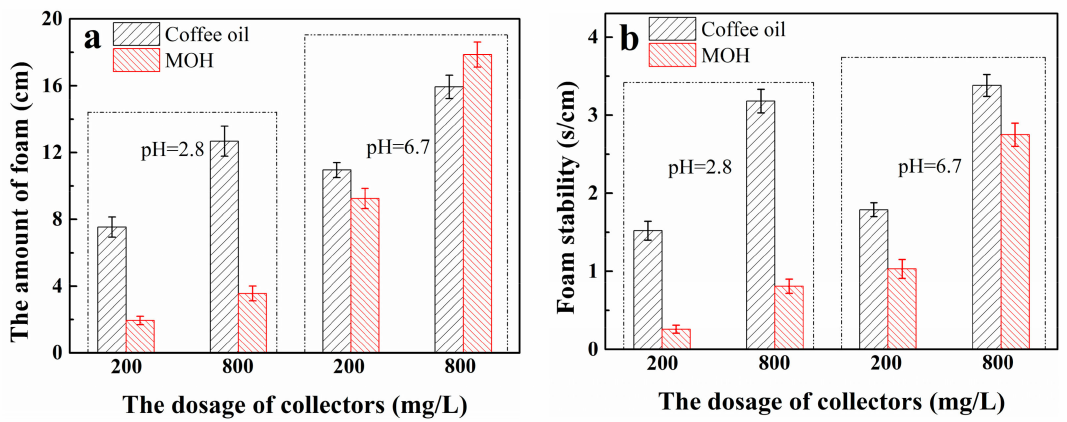
Figure 5. The volume of foam ( a ) and foam stability; ( b ) as a function of the dosage of